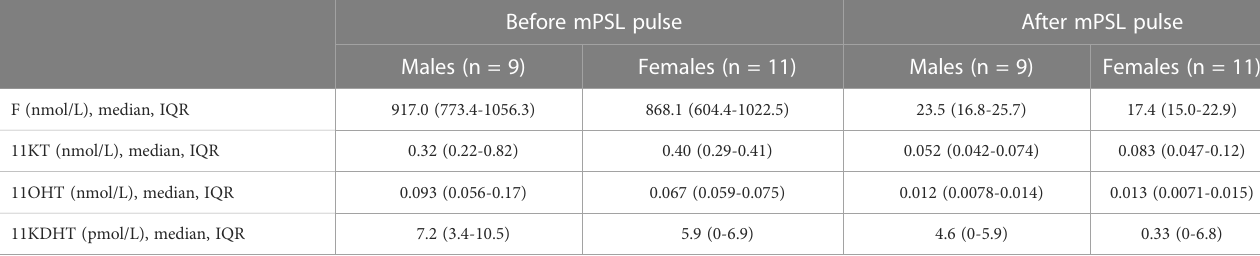
TABLE 3 Sex difference in steroid hormone values (Study 1).